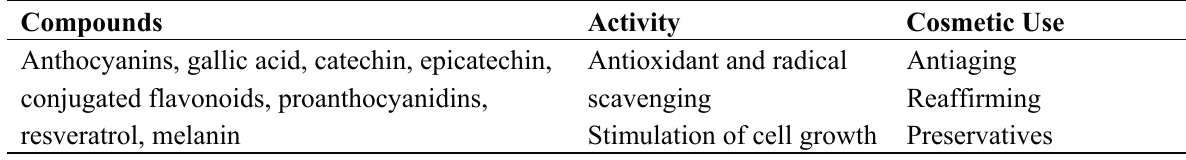
Table 2. Examples of biological activities of grapes and their cosmetic application.